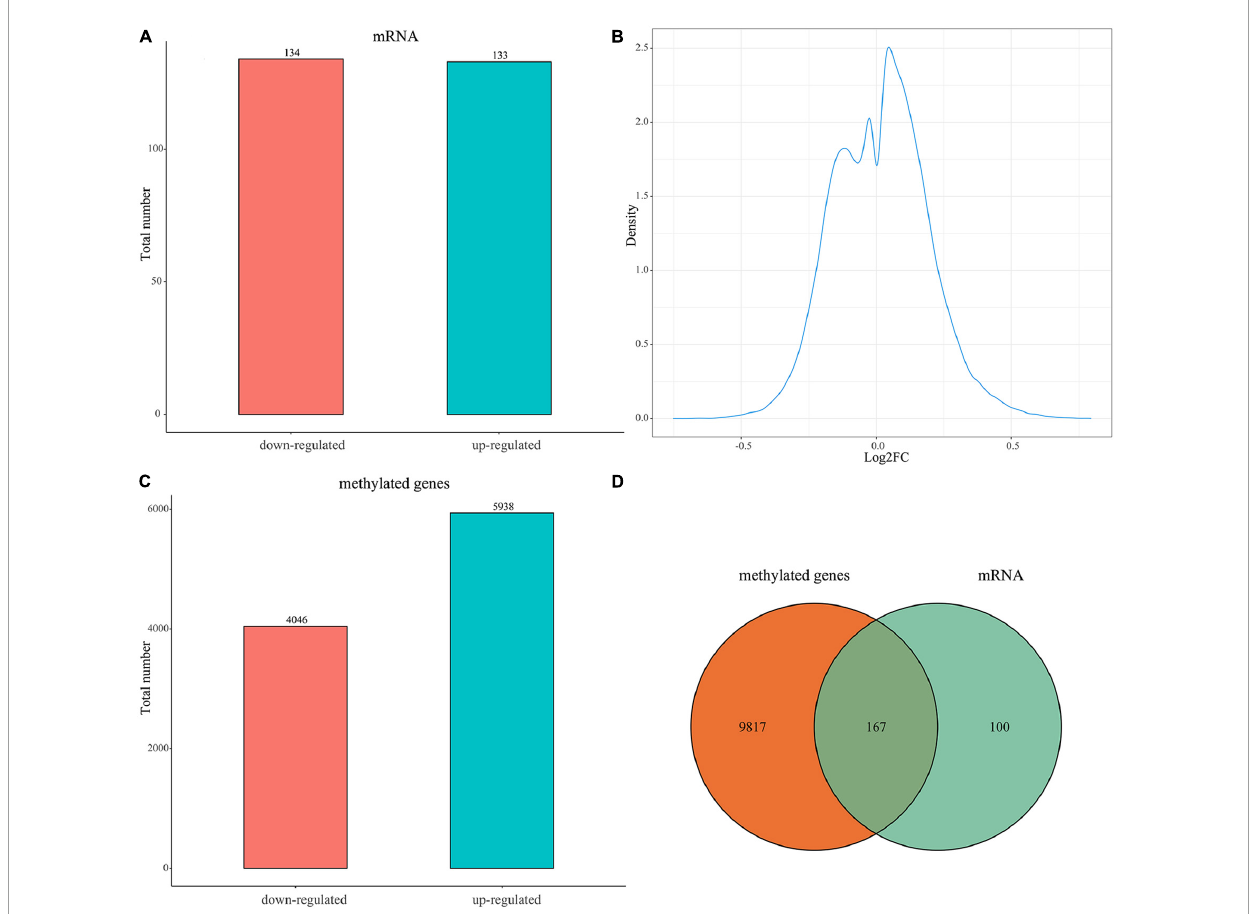
FIGURE1 Expression of DEGs and DMGs between the uterine fibroid and normal myometrium tissue. (A) Bar plot for differentially expressed genes (DEGs) between the two groups. Red bar, down-regulated DEGs in UFs compared with NM; blue bar, up-regulated DEGs in UFs compared with NM. (B) Distribution characteristics of log2FC of differential methylation probes. The X-axis is the log2FC value of the differential methylation probe (UFs vs. NM). (C) Bar plot for differentially methylated genes (DMGs) between the two groups, Red bar, down-regulated DMGs in UFs; blue bar, up-regulated DMGs in UFs compared with NM. (D) Venn diagram of DMGs and DEGs, the overlapped part is used for further analysis. NM, normal myometrium, UFs, uterine fibroids.